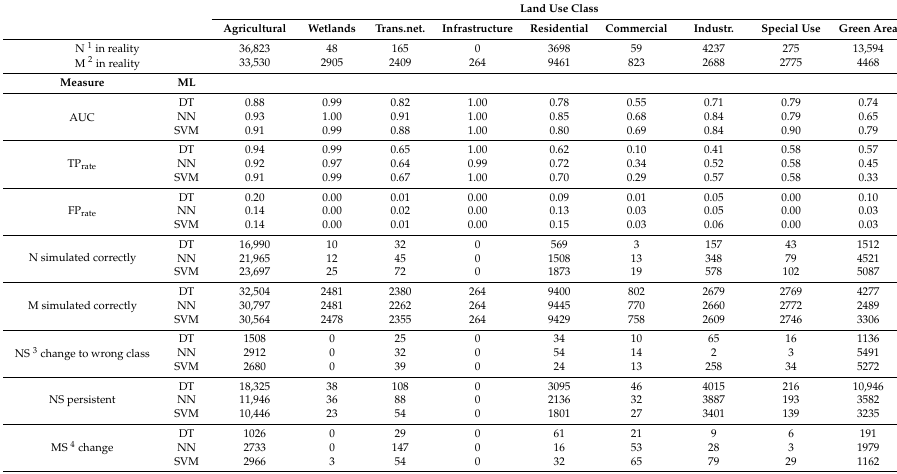
Table 4. Effectiveness of the attribute selection when applied to building models based on three maps comparison